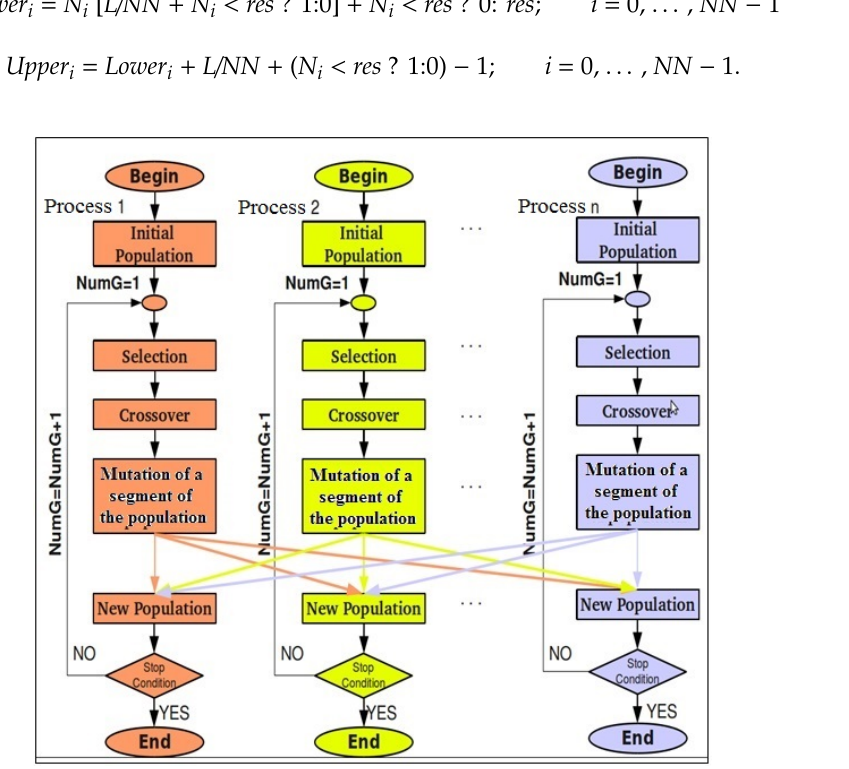
Figure 5. General scheme of the grid-based genetic algorithm (GGA) algorithm.